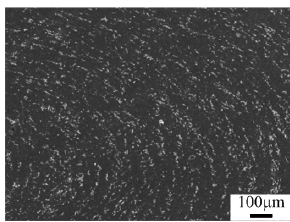
Figure 5. Scanning electron microscope (SEM) image of the distribution of the reinforcements in alloy A after isothermal compression.